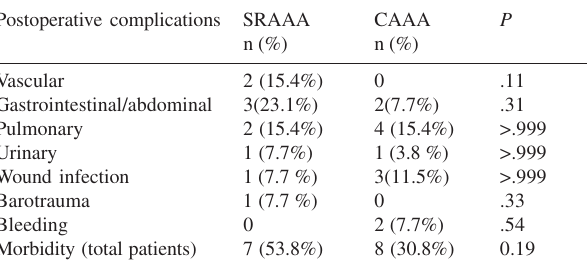
Table 4 - Postoperative complications in 13 patients with SRAAA and 26 AAA controls (CAAA). More than 1